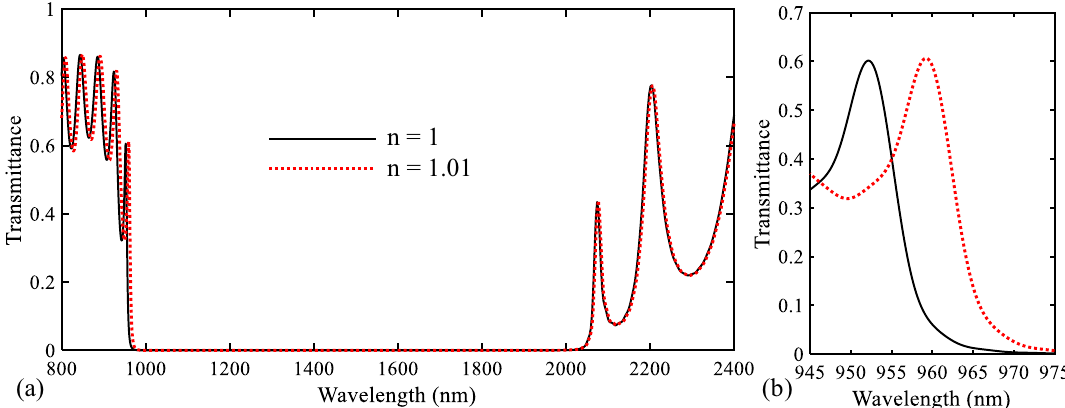
Figure 13. Transmission spectra of the proposed biosensor II for n = 1 and n = 1.01 in different wavelength ranges.